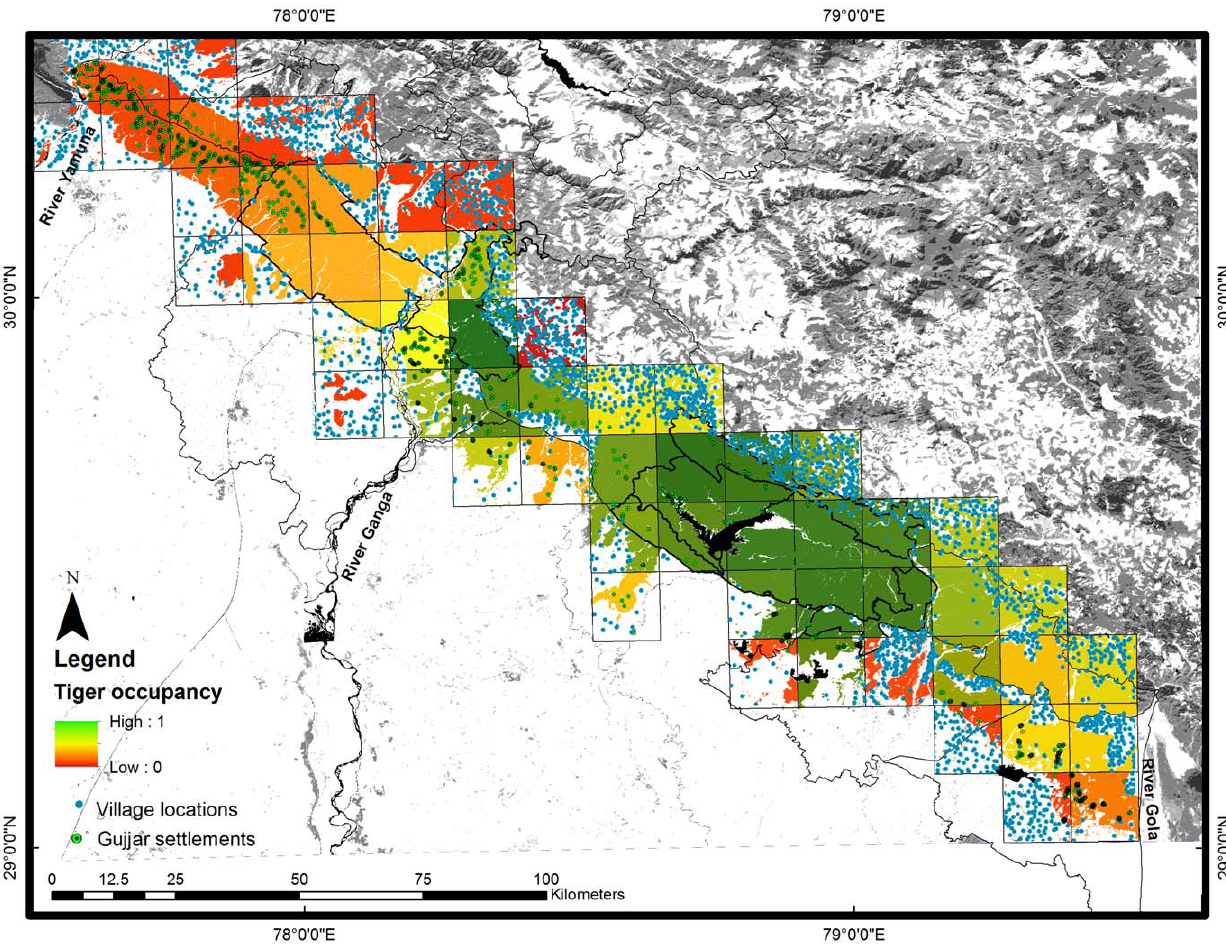
Figure 4. Occupancy of tigers in the western Terai Arc Landscape. Model averaged probability of cell specific occupancy for tigers in relation to human settlements in the western Terai Arc Landscape, India, 2009–10.